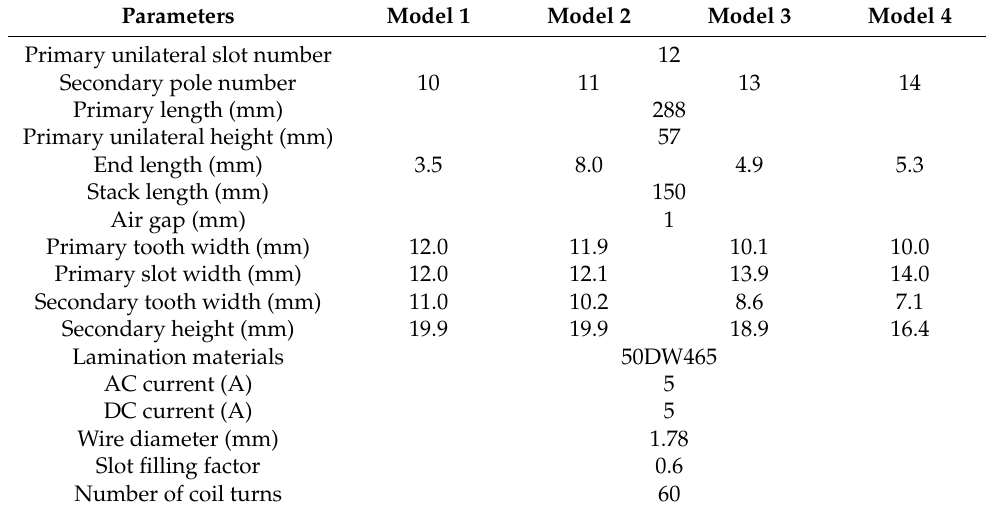
Figure 4. The DCB ‐ VRLMs with different combinations of P a / N sp / P dc . ( a ) Model 1: 4/10/6. ( b ) Model 2: 5/11/6. ( c ) Model 3: 7/13/6. ( d ) Model 4: 8/14/6. Table 2. Key Parameters of DCB ‐ VRLMs.